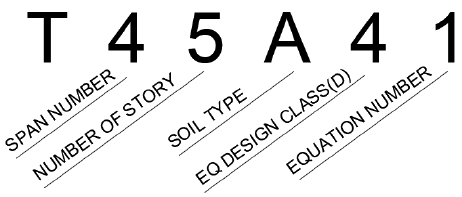
Figure 7. Codes of structural models. In the relevant section of the TBEC-2019, the columns are dimensioned and reinforced using three formulas and reinforcement lower limits for the dimensioning of vertical load- bearing elements in the models selected as framed structural systems with high ductility levels. Since the formulas used in this study do not depend on the soil type, the column dimensions and reinforcement amounts do not change depending on the soil type. For this reason, 144 models depending on the parameters were analyzed in this study. However, only 36 of these models have different column cross-sections. Column dimensions and selected reinforcements of 36 models with different column cross-section values are shown in Table